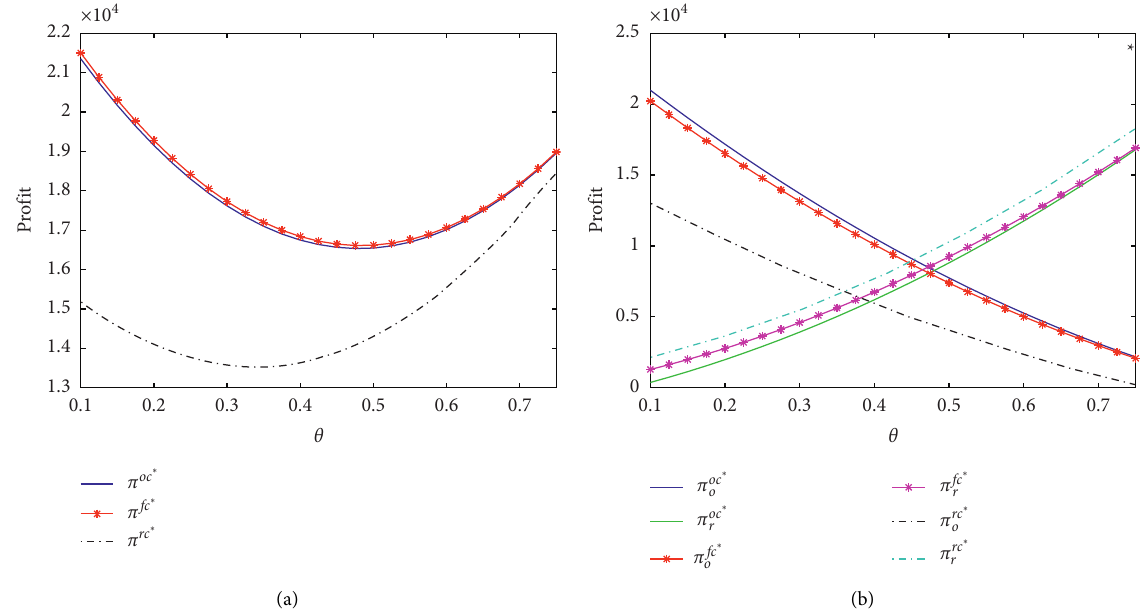
Figure 4: Effect of θ on the DCR’s system profit: (a) the total system profit; (b) the channel profit.